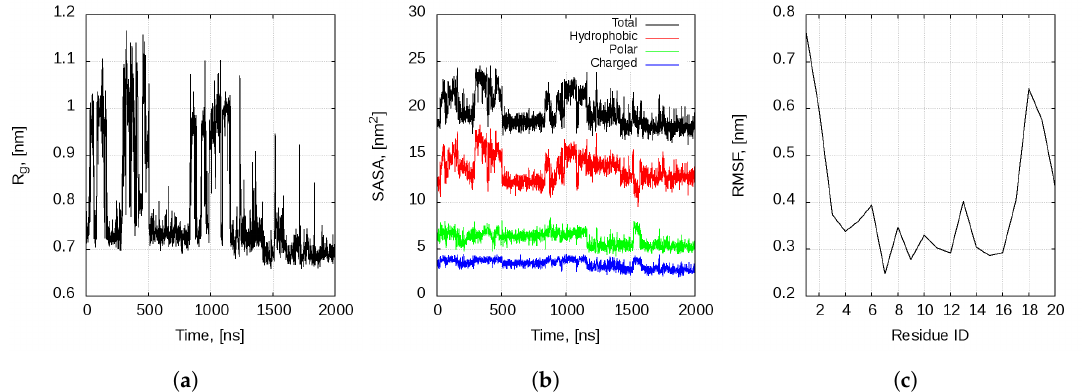
Figure 1. Time evolution of the peptide: ( a ) gyration radius; ( b ) SASA; and ( c ) root mean square fluctuations per residue of monomeric bombinin H2 in water.